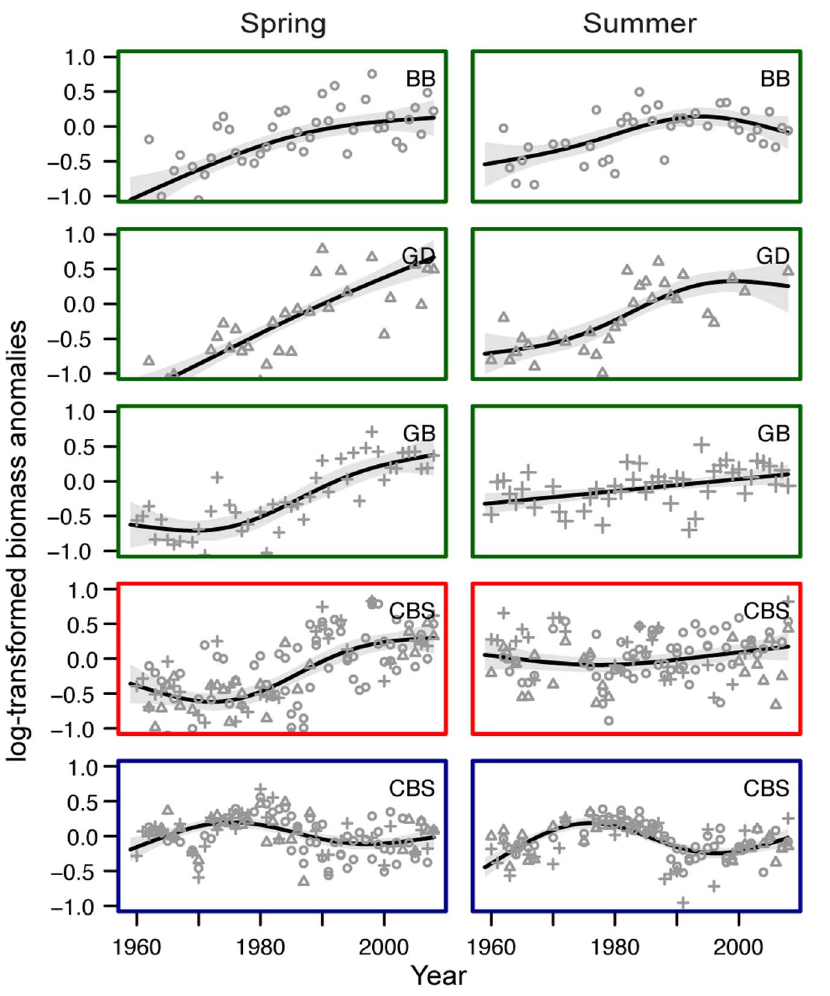
Figure 2. Observed and predicted long-term trends based on the best performing Generalized Additive Model (GAM). Spring and summer biomass anomalies of Acartia spp. (green boxes), significantly differed between the Bornholm Basin (BB), the Gdansk Deep (GD), and the Gotland Basin (GB), while trends for Temora longicornis (red boxes), and Pseudocalanus acuspes (blue boxes) were not basin-specific and rather consistent within the entire Central Baltic Sea (CBS) region. Open circles (BB), triangles (GD) or crosses (GB) represent the observed values in each basin, while the continuous lines indicate the predicted trends from the GAM based on basin-specific smoothers or a single smoother fore the entire CBS region. The shaded areas indicate the pointwise 95% CI.